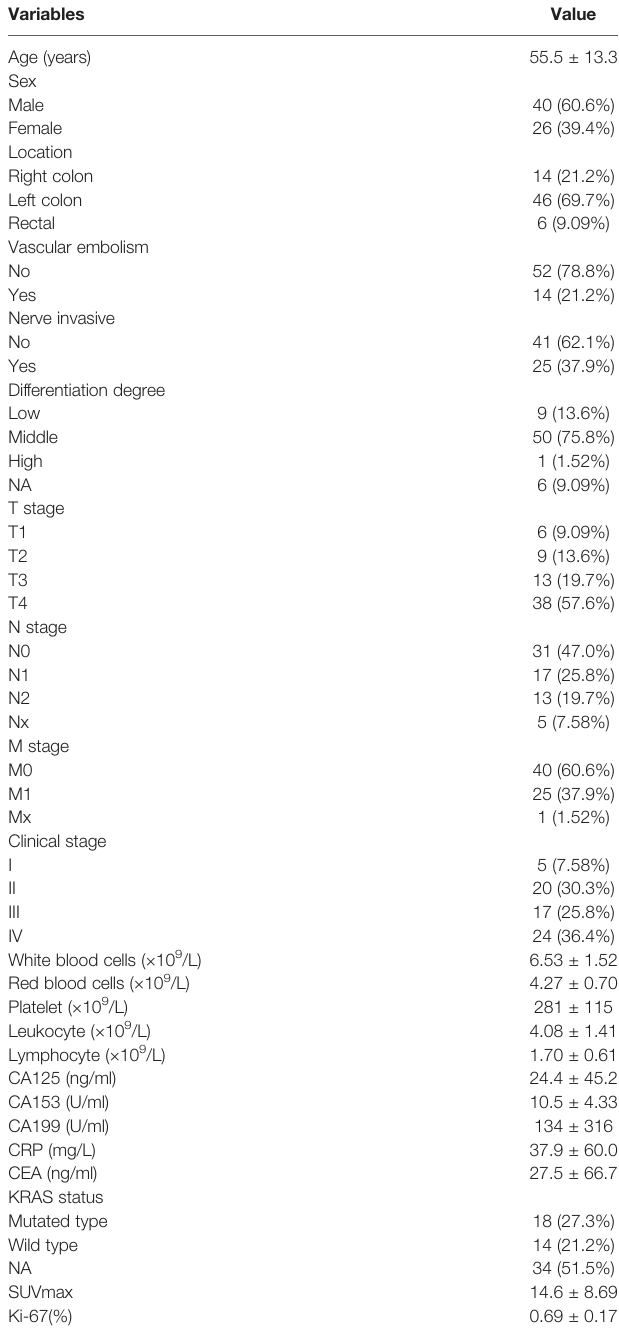
TABLE 1 | Clinical characteristic of CRC